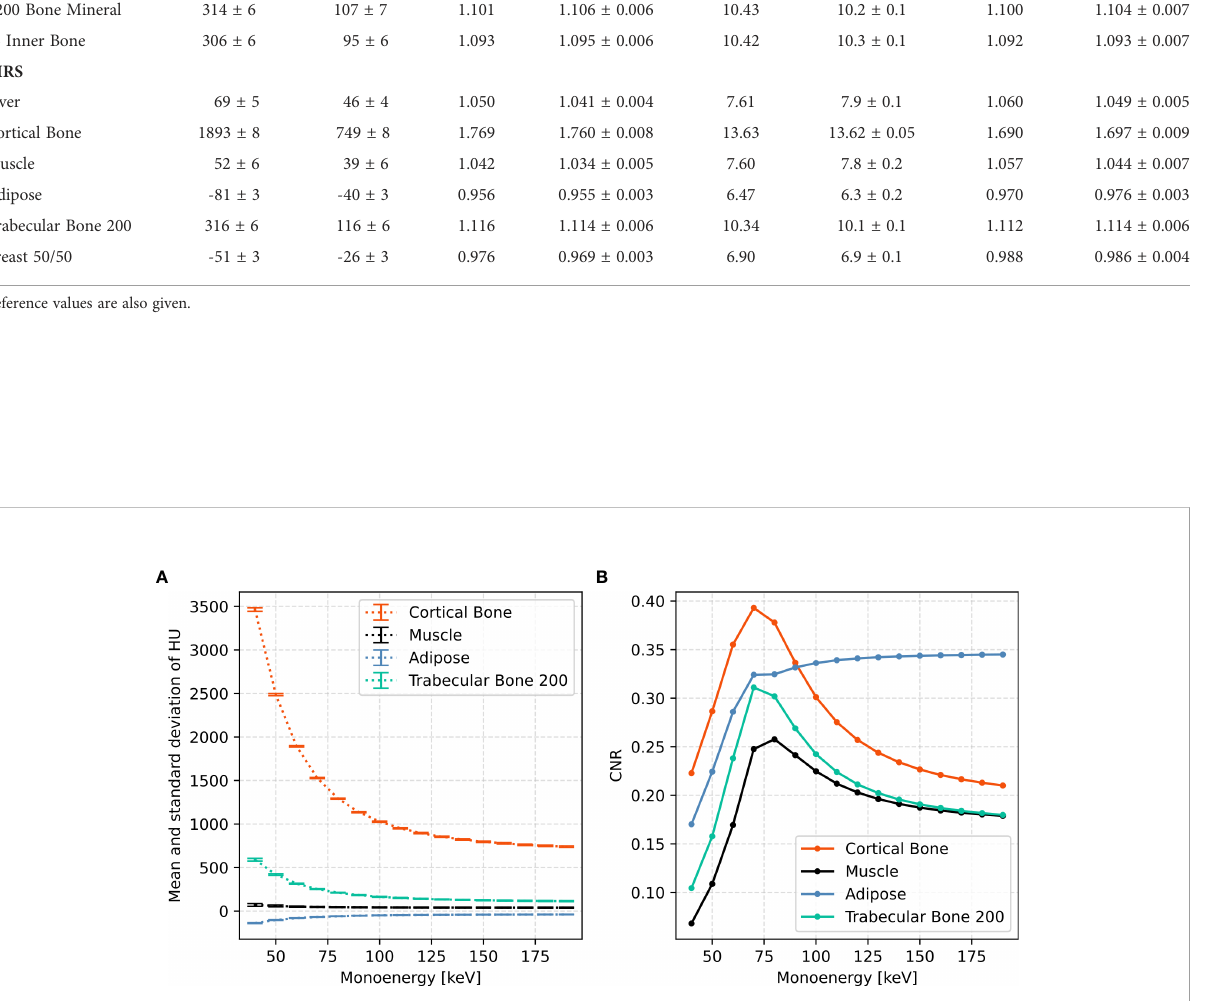
FIGURE 4 (A) Mean (HU mean ) and standard deviation (HU std ) of CT numbers and (B) the corresponding CNR at monoenergies ranging from 40 to 190 keV in 10 keV increments for four CIRS inserts: Liver , \textit{Cortical Bone}, Muscle , and Adipose . CNR was calculated by CNR=(HU mean /1000+1)/ HU std